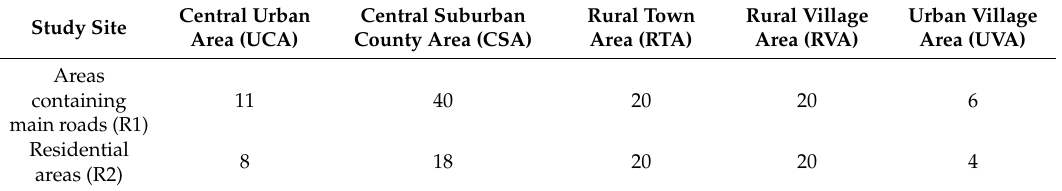
Table 1. Numbers of sampling sites in each area along the urban-suburban-rural